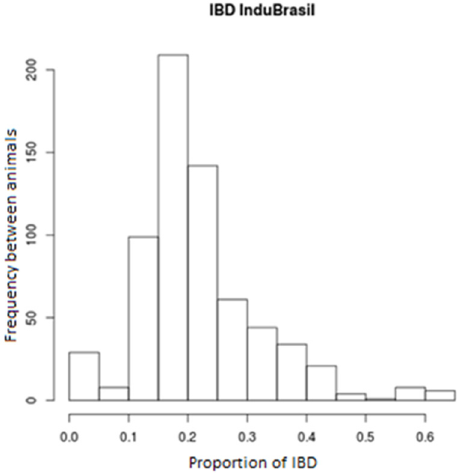
Figure 2. Shared allele’s percentage between animals (IBD).